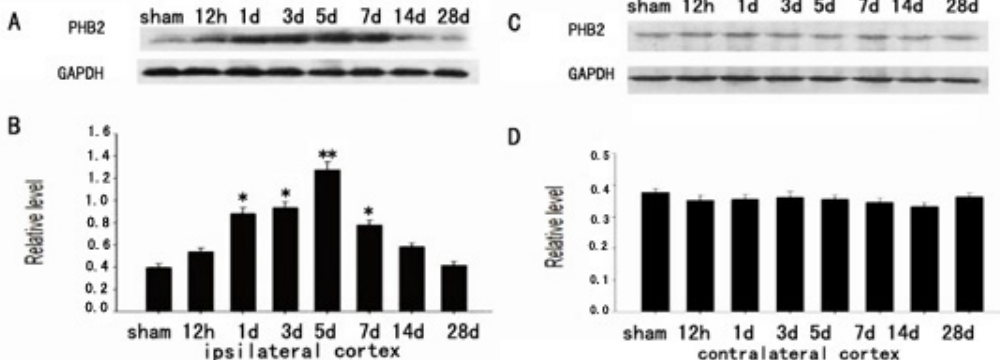
Figure 1. The expression of PHB2 in brain cortex by Western Blot during TBI. Western